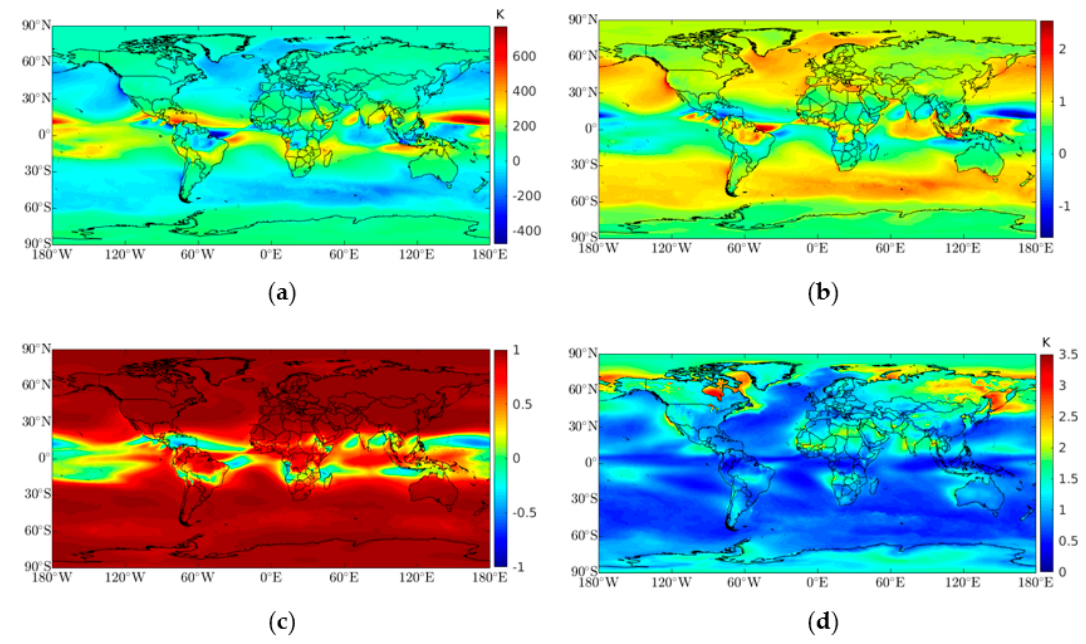
Figure 6. ( a , b ) α and β regression coe ffi cients, obtained using 20 years of monthly ERA5 data, which were used to estimate the weighted mean temperature ( T m ) from the surface air temperature ( T s ). ( c ) Pearson correlation coe ffi cient between the T m obtained using ERA5 numerical integration at each grid point and T s . ( d ) RMSE between T m obtained using α , β , and T s , and the T m obtained using ERA5’s numerical integration (see Equation (5)). The estimation of the coe ffi cients in the tropic regions could generate artefacts, especially over the sea, when T s did not vary over a range large enough to get a satisfactory estimation of the